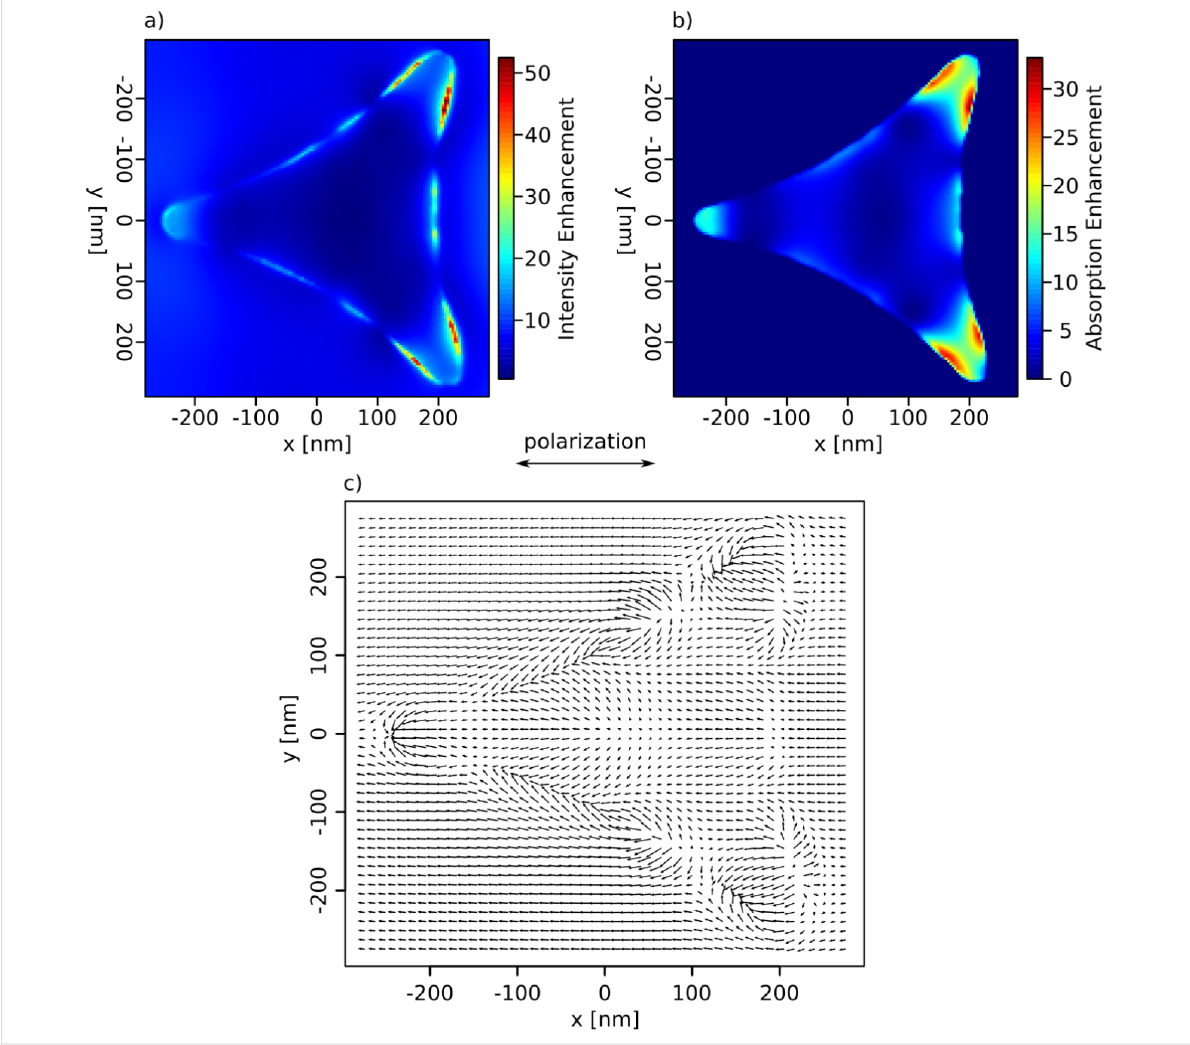
Figure 6: (a) Calculated field intensity enhancement, (b) dissipation, and (c) field distribution for a nanotriangle like in Figure 4. (The model structure on which the simulation was based is depicted in Figure S2 in Supporting Information File 1). The polarization of the incident laser radiation was here horizontal. The simulation volume was 1 × 1 × 1.2 µm 3 with "perfectly matched layer" boundary conditions. The meshing was set to automatic mode far from the triangle and a manually refined mesh with a cell size of 1.3 × 1.3 × 0.5 nm 3 was added around the